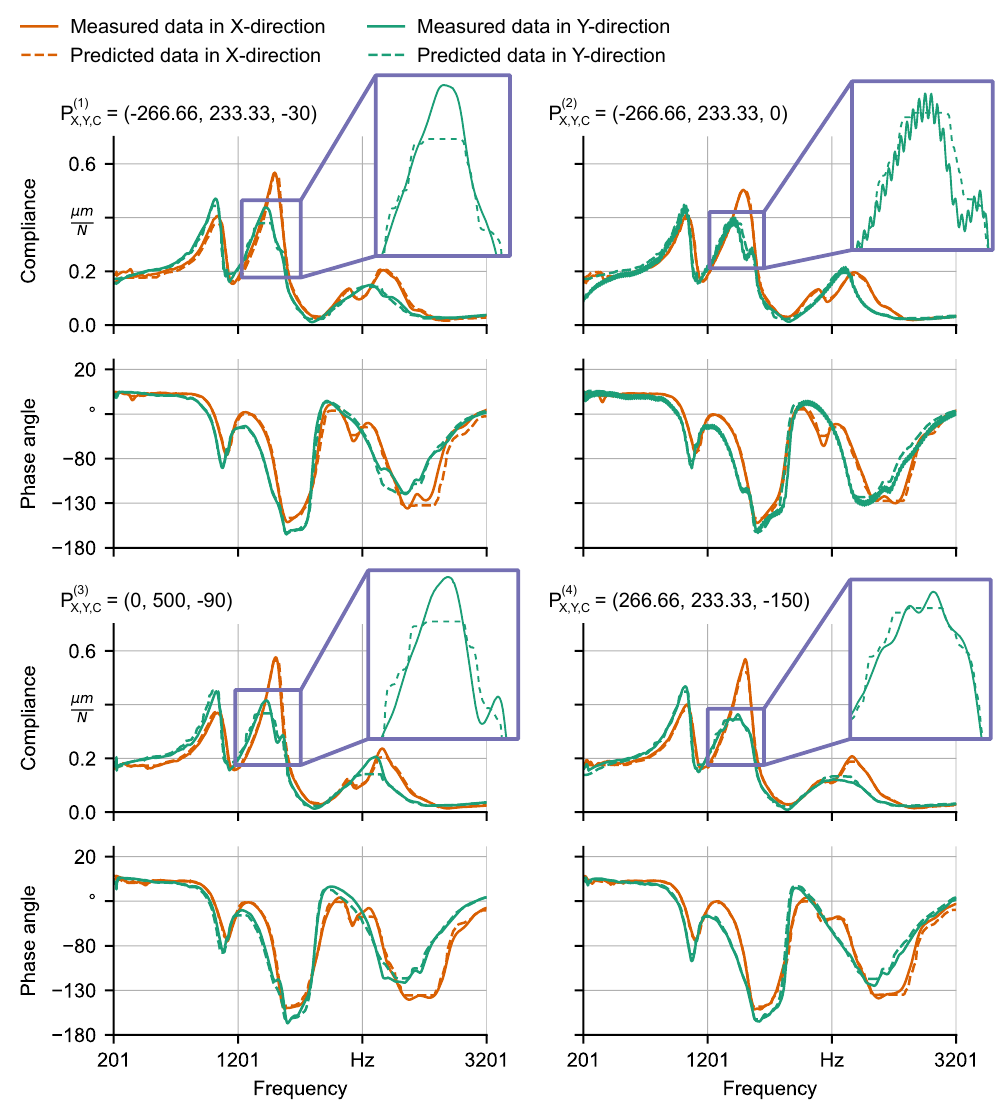
Figure 5. Predicted and measured FRFs using machine tool M 1